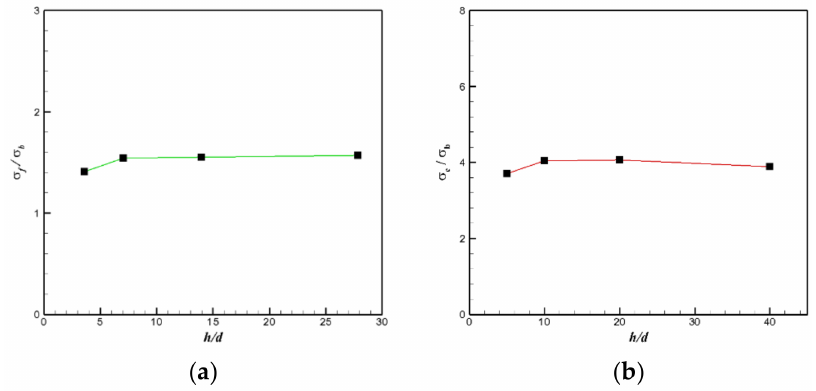
Figure 10. Effect of relative particle size on ( a ) flexural strength; ( b ) compressive